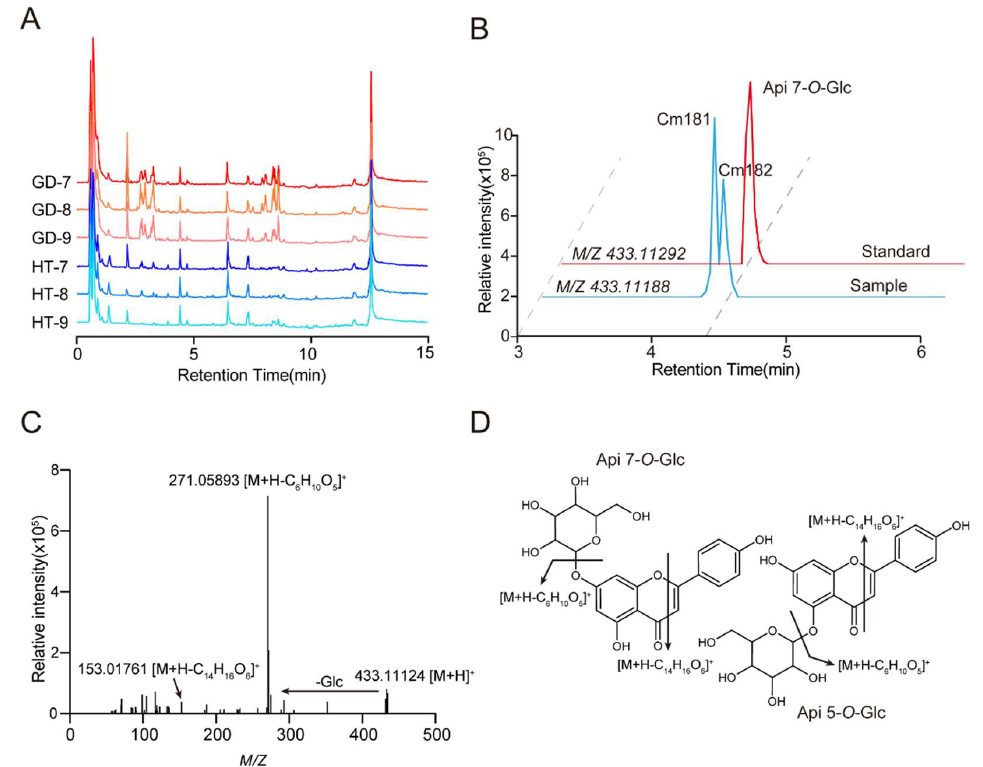
Figure 3. Detection and identification of secondary metabolites by UHPLC–HRMS. ( A ) TIC (total ion chromatogram) of metabolites in different varieties and stages of coconut flesh obtained from UHPLC–MS/MS analysis. ( B ) EIC (extracted ion chromatogram) of apigenin 5- O -glucoside and apigenin 7- O -glucoside detected at 4.28 min and 4.35 min in sample. Apigenin 7- O -glucoside detected at 4.35 min in standard. ( C ) MS/MS spectra at m / z 433.11124, and the metabolite was identified as apigenin 7- O -glucoside. ( D ) The molecular structure of the apigenin 7- O -glucoside and apigenin 5- O -glucoside and their general fragmentation rules.